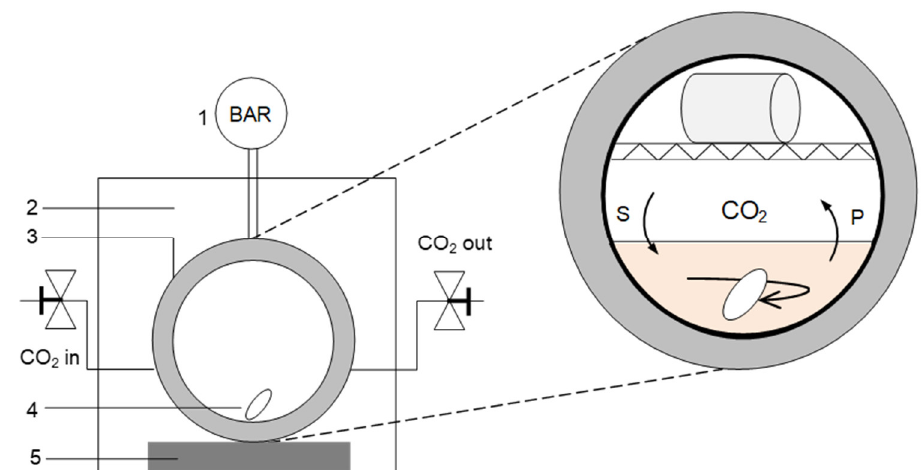
Figure 14. High pressure apparatus: 1—Pressure transducer, 2—Thermostated water bath, 3—Stainless steel cylindrical cell, 4—Magnetic stirring bar, 5—Stir Plate.